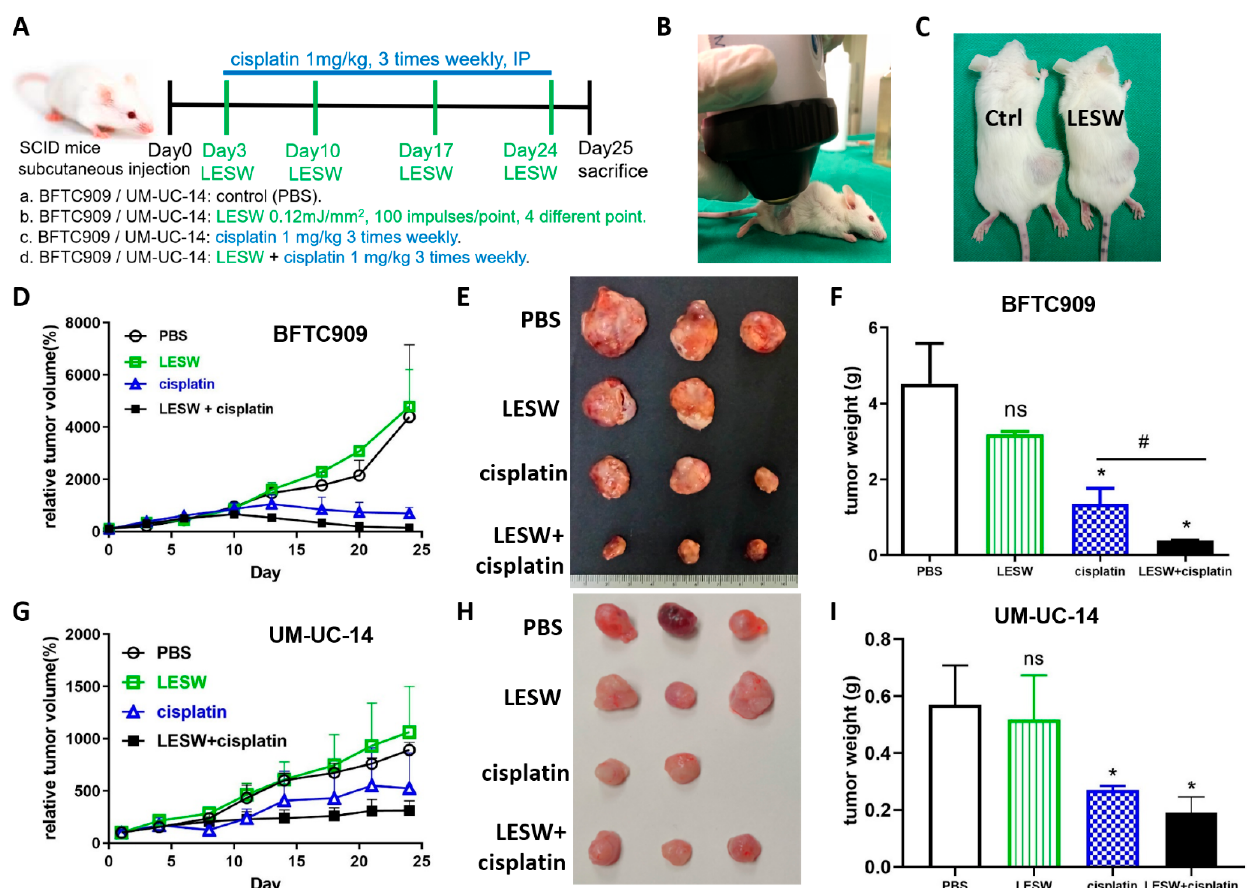
Figure 2 . Shock wave treatment augmented cisplatin effects in vivo. ( A ) Flowchart showing the timeline and treatment methods of the experiment. ( B ) Experimental apparatus for in vivo shock wave exposure. The shock waves were produced by Duolith SD-1 (Storz Medical, Tagerwilen, Switzerland). The xenograft tumour was directly exposed to shock wave treatment through the ultrasound transmission gel. ( C ) Shock waves did not cause significant damage to the skin over the tumour. Relative tumour volumes of BFTC909 ( D ) and UM-UC-14 ( G ) xenografts in SCID mice after treatment for 25 days; the initial tumour volumes reached 100–150 mm 3 . Tumour diameters were measured twice a week using vernier callipers. BFTC909 ( E ) and UM-UC-14 ( H ) representative tumours in each group. The mass of BFTC909 ( F ) and UM-UC-14 ( I ) tumours was weighed after the mice were sacrificed. Error bars represent mean ± S.E.M. The statistical test performed was one-way-ANOVA, * p < 0.05 versus control group (PBS), # p < 0.05 versus CDDP group, ns indicates no significance.